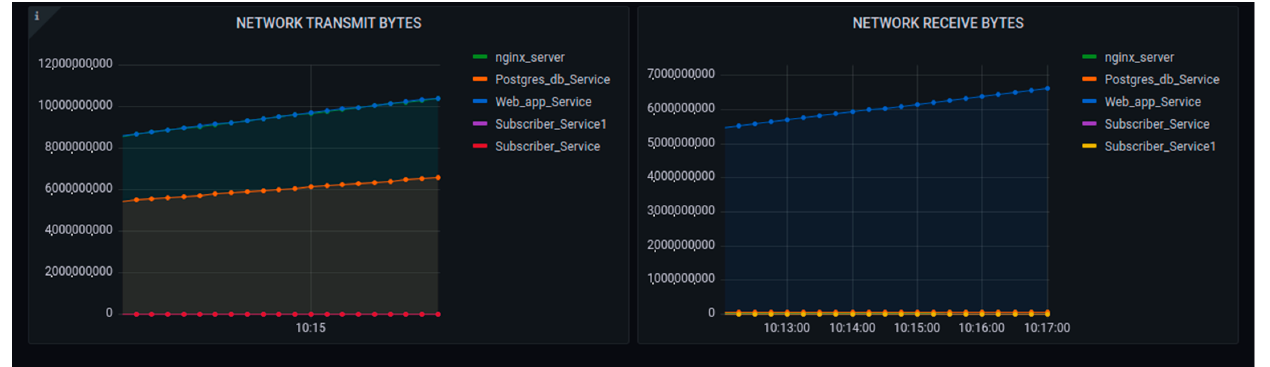
Figure 21. Performance of the platform after scaling up with 1,000,000 requests: memory and CPU usage.